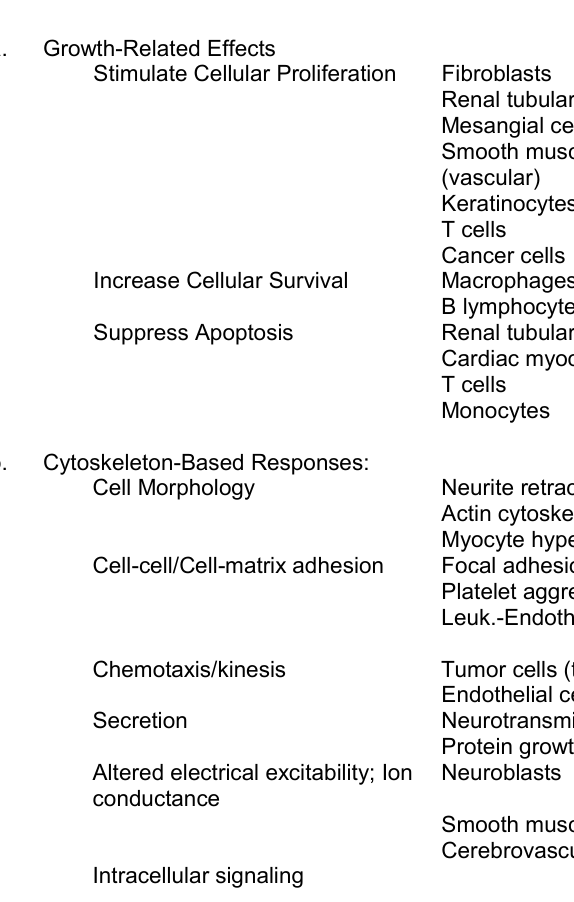
Biological Activities of LPA and